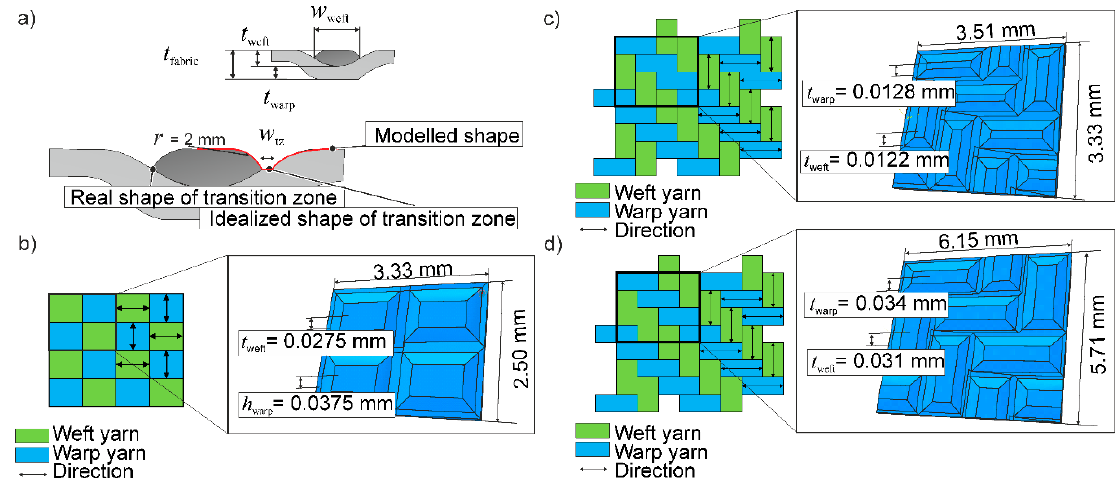
Figure 8. Simplified surface structure of the fabric for numerical modeling: ( a ) structural dimensions of woven fibers; ( b ) dimensions of plain woven type shape; ( c ) dimensions of 80 g/mm 2 twill woven type shape; and ( d ) dimensions of 280 g/mm 2 twill woven type shape.